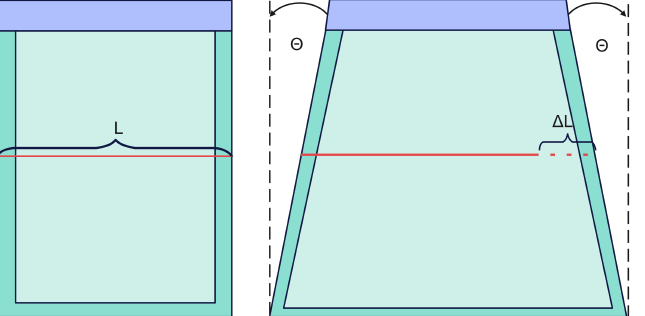
Figure 4. Geometric representation of the reduced-order model. Left is the cross-section of a single unit in a profile. The compliment Mold Star 15 cavity (green) and Smooth-Sil 950 strain-limiting layer (blue) are shown. The reduced model replaced the entire unit with a single line (red) of length L . The right shows the change in geometry experienced by each unit when pressure is applied. The cavity expands significantly, while the strain-limiting layer does not. This is represented by an increase in length ∆ L and a change in angle for the two ends of the line Θ